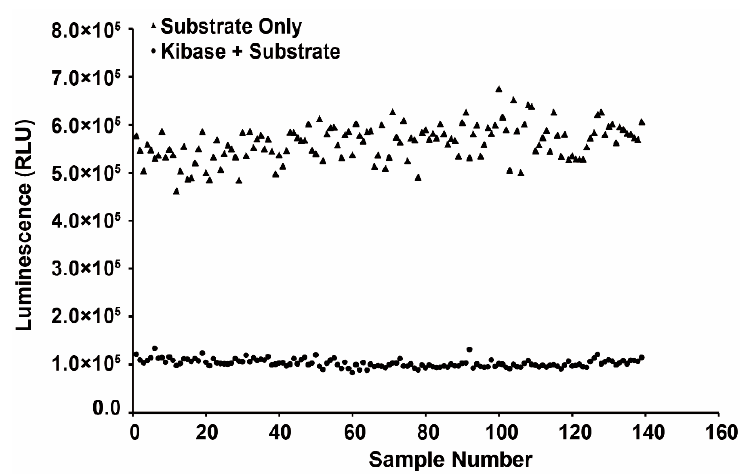
Figure 4. Evaluation of the screening model for CLK1 inhibitor. The calculated Z ′ value was 0.70. RLU = relative light unit.